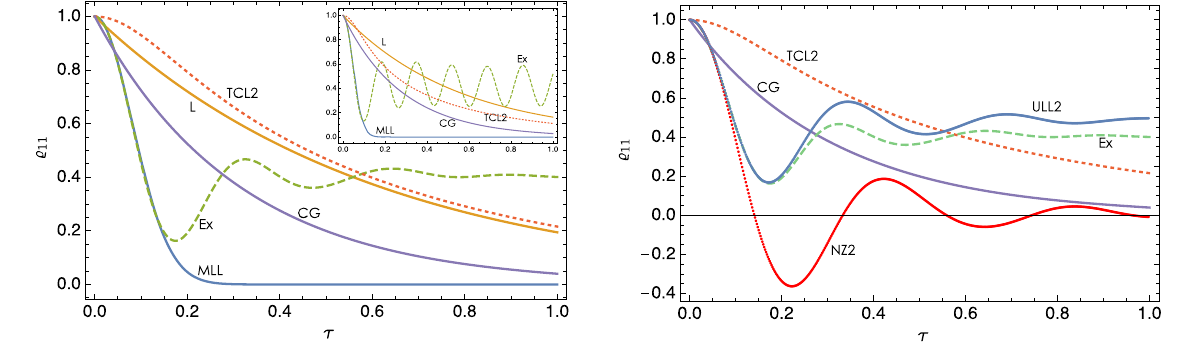
FIG. 4. Damped harmonic oscillator. Left panel: Population of the first excited state of the system harmonic oscillator vs time for ω 1 and ω 5 (all in dimensionless units) when the system is initially in the state j ψ ð 0 Þi 0 ¼ c ¼ oscillators ( M → ∞ ) at zero temperature. For the numerical solution of the exact dynamics, we have assumed M ¼ 255 , g 0 . 1 k , where 1 ≤ k ≤ M . The labels CG, Ex, L, MLL, and TCL2 denote, respectively, data from the CG, exact, Lindblad, and ω k ¼ MLL, and TCL2 solutions. The inset shows an identical case, except that ω the ULL2, NZ2, CG, TCL2, and exact